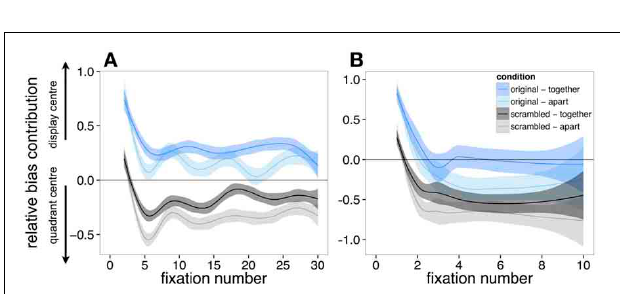
FIGURE 5 | The relative contribution of the quadrant center, and display center on fixation selection when considering (A) all fixations, and (B) only the fixations that landed on the first quadrant that was inspected. Bias toward the display center is at 1, with bias toward the quadrant center bias at − 1. Standard Errors ( ± 1) are shaded. As the lines move toward the ± 1, this represents a stronger contribution of the bias to fixation